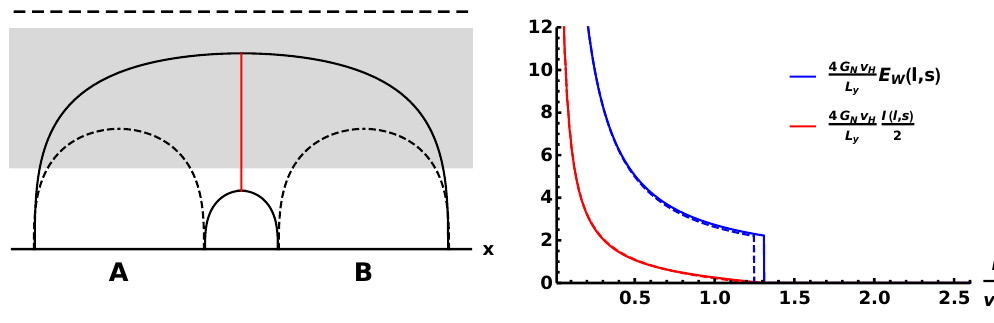
Figure 4 . Left : minimal surfaces in the parallel strip case for the electron cloud geometry with T/µ = 0 . 02 . The disconnected phase of S ( AB ) corresponds to the union of the dashed curves. The connected, I ( A, B ) > 0 , phase on the other hand corresponds to the solid black curves. The dashed black line on the top denotes the black hole horizon while the gray shaded area marks the location of the cloud. The red vertical line corresponds to the minimal surface whose area computes the entanglement wedge cross section in the connected phase. Right : mutual information and entanglement of purification for a parallel strip configuration with separation s/l = 0 . 4 , as a function of strip width l . The point where I ( A, B ) vanishes corresponds to the disconnecting of the entanglement wedge. Thus at this point, mutual information vanishes continuously and the entanglement wedge cross section jumps to zero discontinuously. We also show the results for mutual information and entanglement of purification obtained in the pure RN case (dashed red and blue lines,